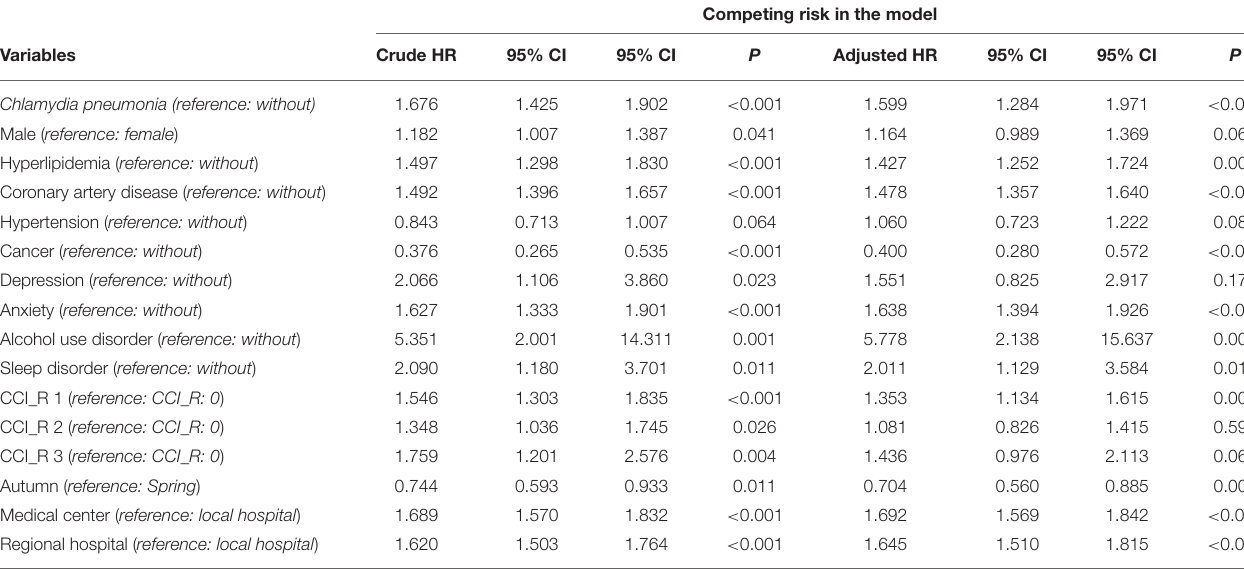
TABLE 2 | Factors for Alzheimer dementia by using the analysis of Fine and Gray’s competing risk